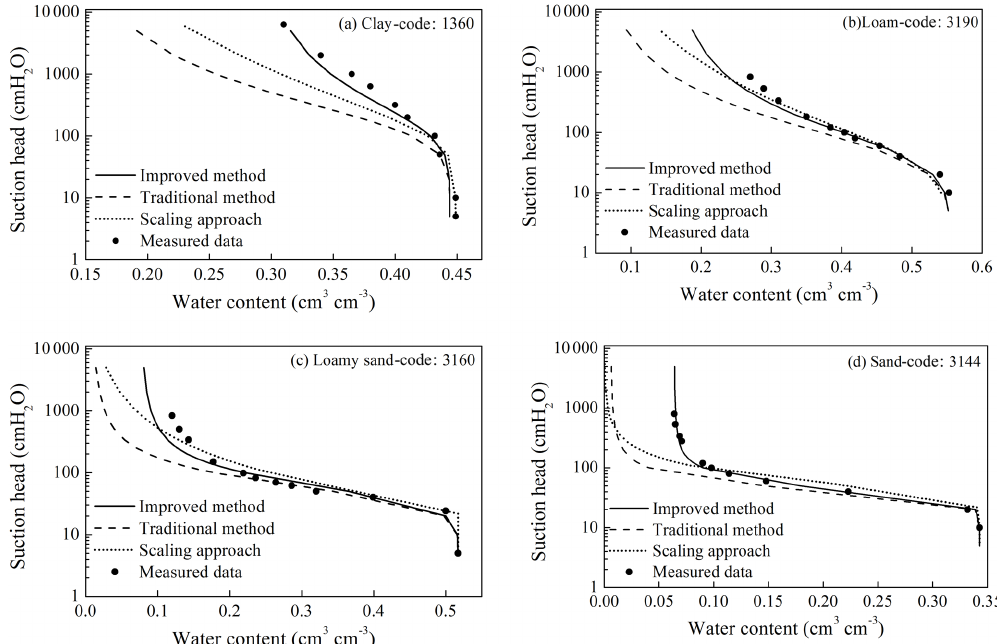
Figure 5. Measured and predicted SWRCs for clay (code: 1360), loam (code: 3190), loamy sand (code: 3160) and sand (code: 3144).